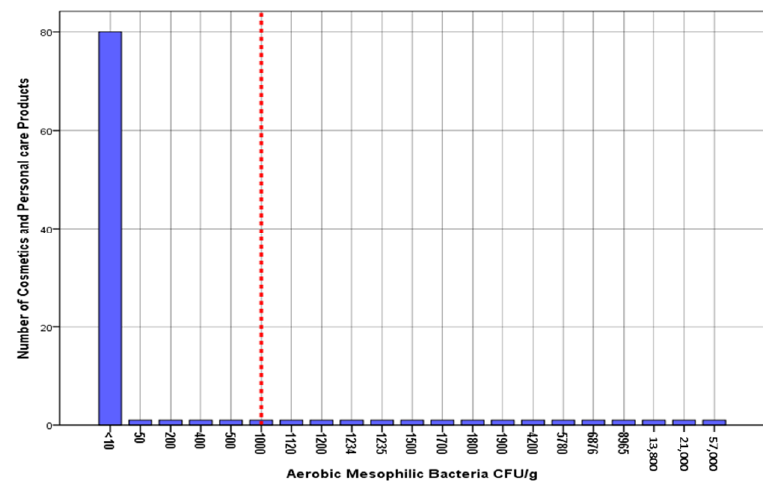
Figure 1. Histogram of the estimated aerobic mesophilic bacteria (CFU / g) for cosmetics and personal care products ( n = 100). The vertical dashed line shows the microbiological maximum limits according to BS EN ISO